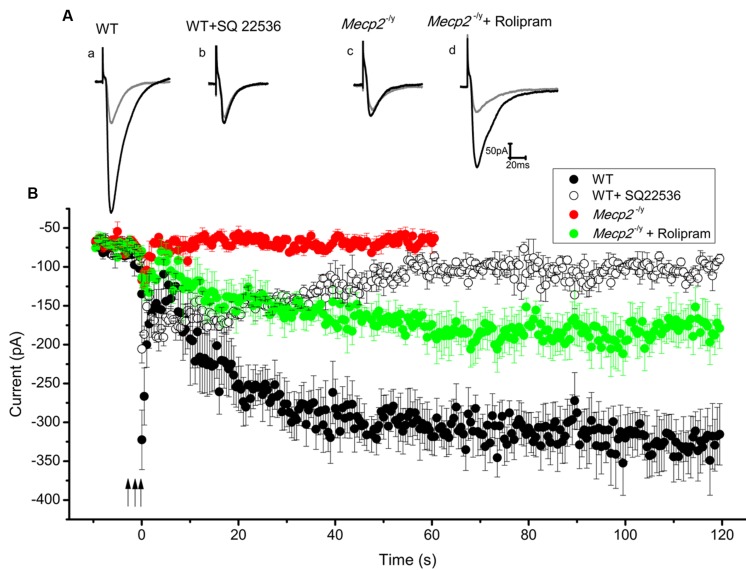
Three tetanic pulses separated by 10 min were applied to Schaffer collaterals for 1 s each (represented by the arrows) to evoke cAMP dependent LTP. Traces from individual experiments are shown in (A) and the averaged EPSC amplitude time course in B. EPSC amplitude modulation in the WT CA1 neurons is shown in (Aa) (gray trace is control and black is during LTP) and filled circles in (B) (n = 5). Adenylyl cyclase inhibitor SQ 22536 (100 μM) blocked this effect when applied along with the tetanus (for 30 min), (Ab) (gray trace is control and black is after SQ22536 treatment) and open circles in (B) (n = 3). Same tetanic stimulation protocol failed to evoke LTP in Mecp2-/y CA1 neurons, (Ac) (gray trace is control and black trace represent the averaged EPSCs∼60 min after the tetanus) and red filled triangles in (B) (n = 5). Treatment of slices with rolipram (for 60 min starting 5 min before the first tetanus) caused a delayed but steady increase in the EPSC amplitude of Mecp2-/y CA1 neurons; (Ad) (gray is control and black is during LTP) and green filled triangles in (B) (n = 4).